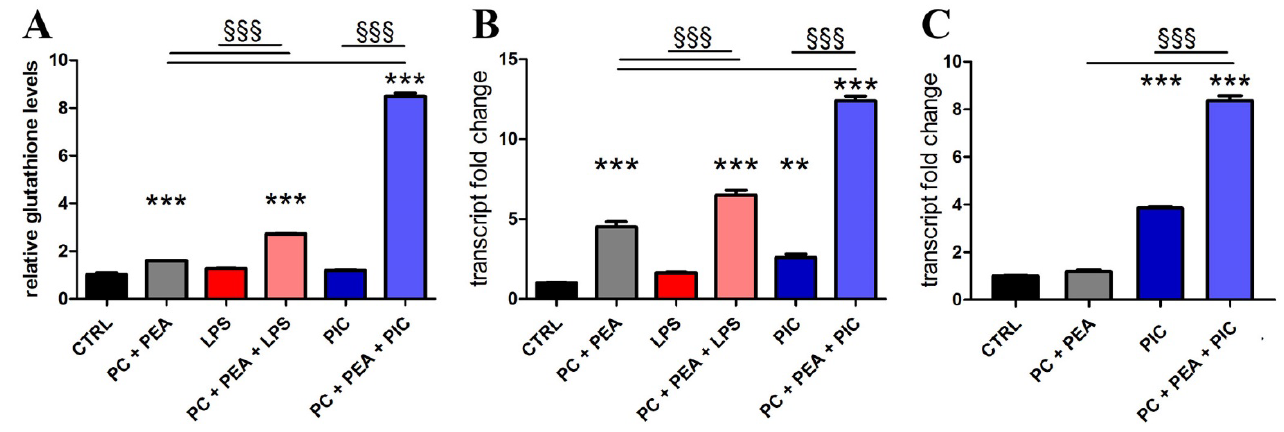
Figure 3. PC and PEA potentiate the antioxidant defenses of the cells. Cells were treated for 24 h with 20 µg/mL bacterial antigen lipopolysaccharide (LPS) or with 10 µg/mL Poly(I:C) (PIC), 1 µM PC and 1 µM PEA, alone or in combination. The amount of total GSH was measured in Beas-2B ( A ) and the mRNA expression of glutamate-cysteine ligase catalytic subunit (GCLC) was detected by qRT-PCR both in Beas-2B ( B ) and HPrEpiC ( C ) cells. Control cells (CTRL) were not treated. Results are means ± SEM. ** p < 0.01 and *** p < 0.001 vs. ctrl; §§§ p < 0.001. The latter statistical significance demonstrates the potentiation of the effect when the combination PC + PEA is used in the presence of inflammatory stimuli vs. the inflammatory stimuli alone or PC + PEA only.